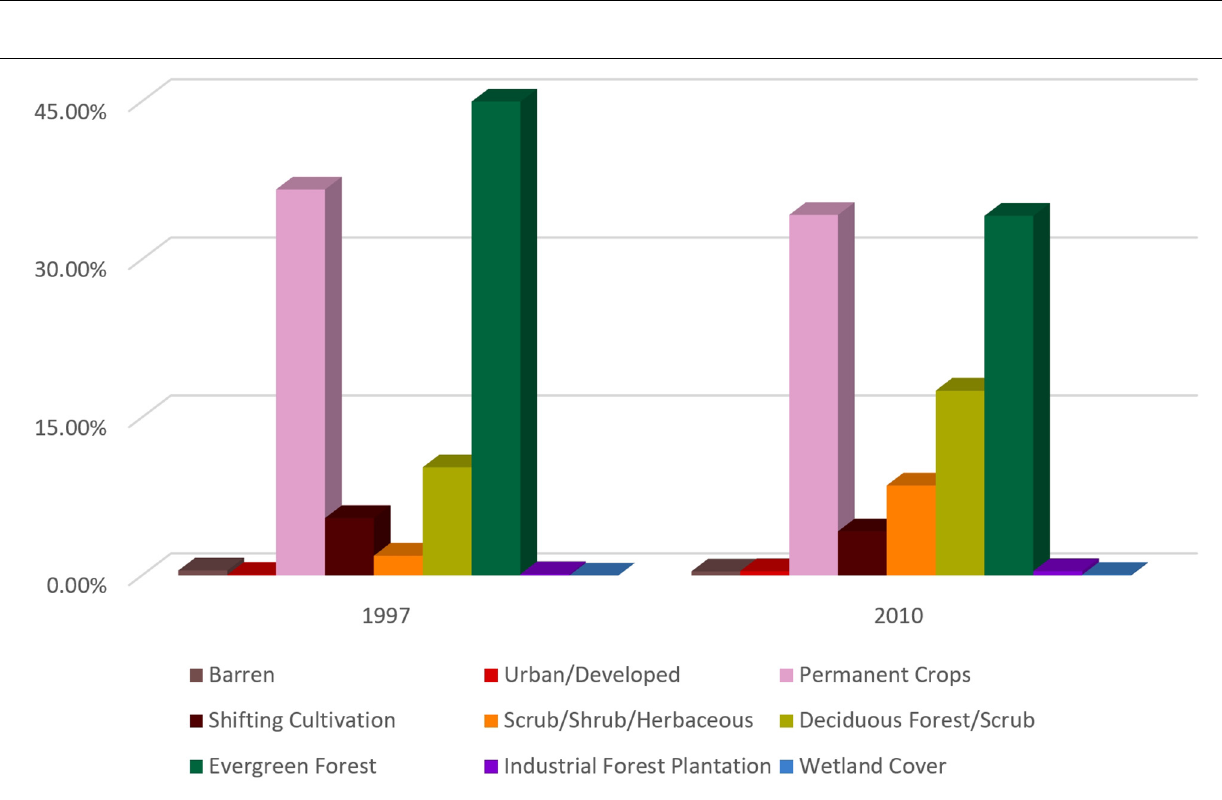
FIGURE 6 | Percent class frequency for the 1997 and 2010 LULC